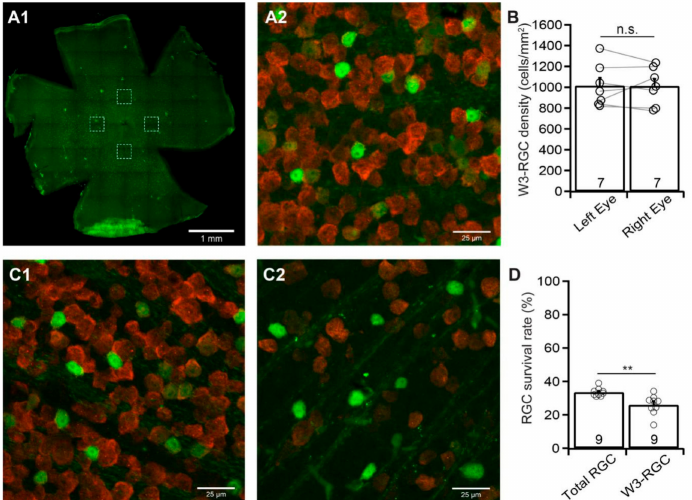
Figure 6. The susceptibility of W3 RGCs to ONC. Similar to other RGC types, the densities of YFP-expressing W3-RGCs of left and right eyes of TYW3 mice without ONC are compared to determine the YFP expression level of the left and right eyes without injury. The density of the YFP-expressing W3-RGCs of left eyes with ONC was quantified, normalized to that of uncrushed right eyes, and compared with the density of anti-RBPMS-labeled RGCs of the same eyes. ( A ) A representative image of a flat-mount TYW3 mouse retina without ONC ( A1 , only showing YFP-expressing W3-RGCs but not anti-RBPMS-labeled RGCs) , and a magnified view of the left dash-line box of A1 to show the anti-RBPMS-labeled RGCs (red) and YFP-expressing W3-RGCs (green) ( A2 ). ( B ) Comparison of the average densities of YFP-expressing W3-RGCs from the retinas of the uncrushed right and left eyes of the same group of TYW3 mice. The di ff erence between the right and left eyes is not statistically significant (number of mice n = 7, paired t -test, p = 0.9561). n.s.: not significant. The circles are individual eyes. ( C ) A representative image from the retina of a TYW3 mouse with the labeling of YFP-expressing W3-RGCs (green) and anti-RBPMS-labeled RGCs (red) without ONC ( C1 ) and seven days after ONC ( C2 ). ( D ) Comparison of the average survival rates of anti-RBPMS-labeled RGCs and YFP-expressing W3-RGCs from the same eyes seven days after ONC. The densities of anti-RBPMS-labeled RGCs and YFP-expressing W3-RGCs of the eyes with ONC are normalized to their uncrushed control eyes for each mouse. The survival rates of YFP-expressing W3-RGCs are significantly lower than that of anti-RBPMS-labeled RGCs from the same eyes (number of mice n = 9, paired t -test, p = 0.0014). The number in each column of panels B and D is n, and the circles are individual results. ** 0.001 < p <